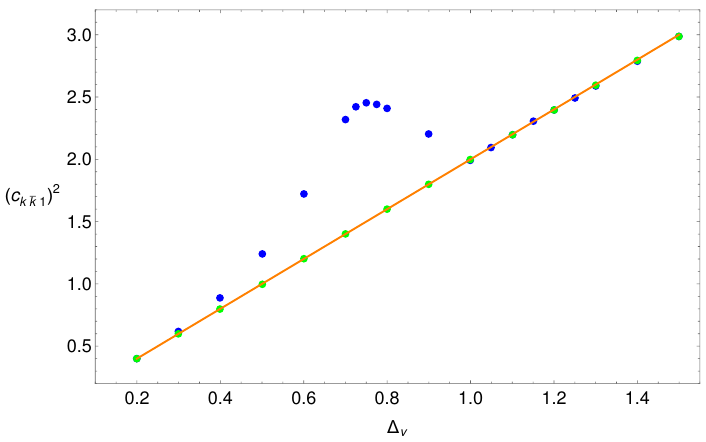
Figure 21 . Same plot as before, with the stronger assumption that the Z 2 odd gap is 3 for the blue points, and additionally that the Z 2 even gap is 4 for the green points. The blue points coincide with the ones of the previous plot for ∆ v < 1 and match the analytic winding mode correlator for ∆ v ≥ 1 . The green points match the analytic correlator in the full range of ∆ v